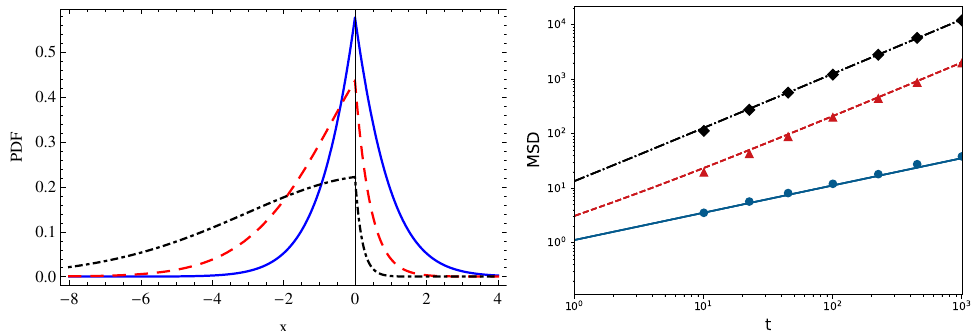
Figure 7. Left panel: PDF (53) at t = 1; right panel: MSD (57) for D x = 1, D y = 1, x 0 = 0, and v = 0 (blue solid line), v = − 2 (red dashed line), and v = − 5 (black dot-dashed